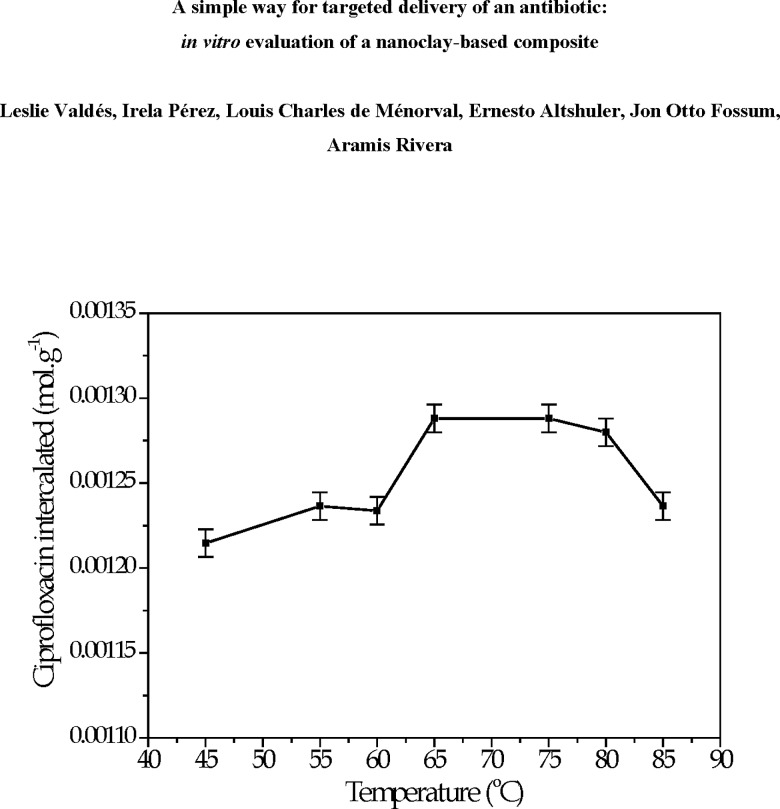
Cipro load onto NaFh from aqueous solution at different temperatures at 1.36 x 10−2 mol L-1 and equilibration time 6 h.